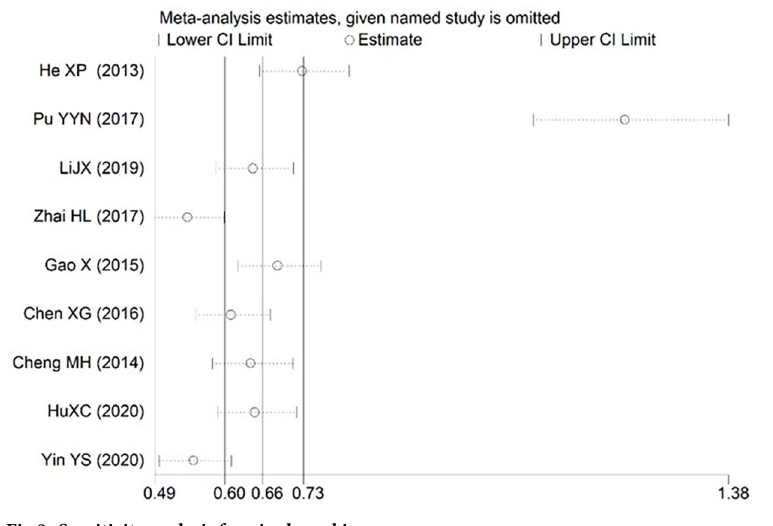
Fig 9. Sensitivity analysis for nipple